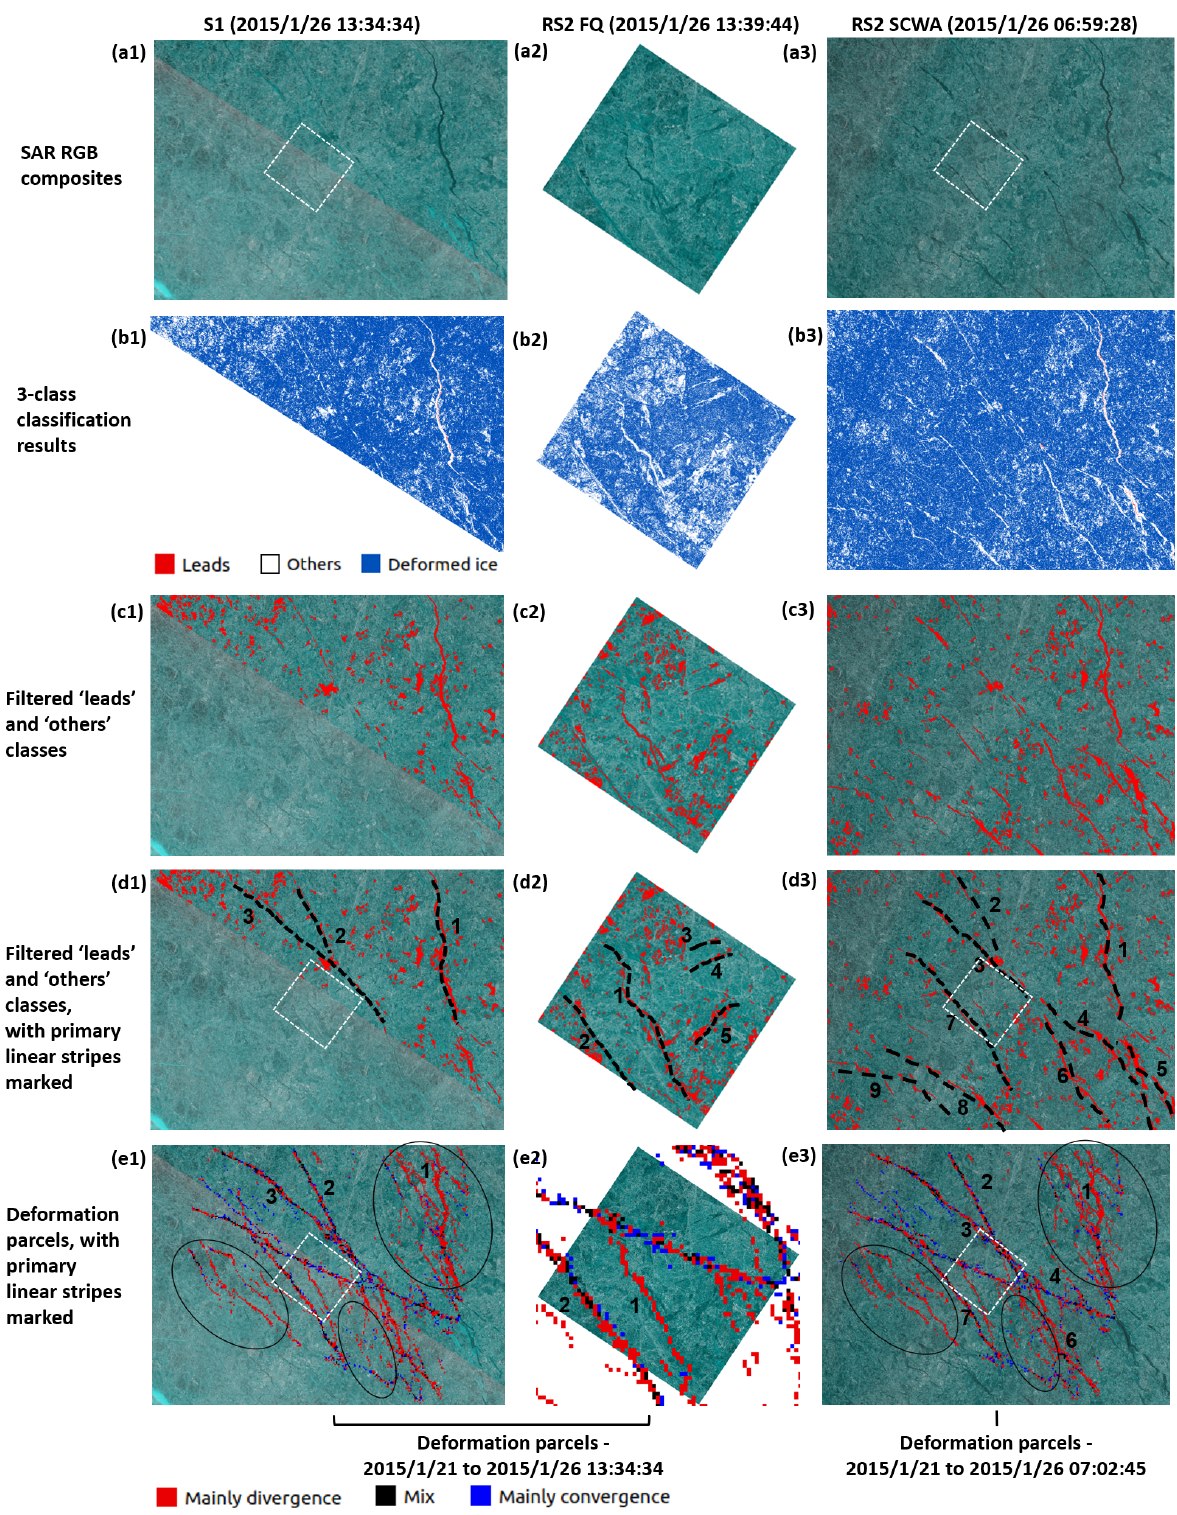
Figure 10. Comparison of classification results and deformation parcels. Classification results (b1–b3) are derived using the GIA classifier retrained using corresponding training sets. The position of the RS2 FQ scene is shown as white rectangles in the wide-swath scenes (a1, a3) .